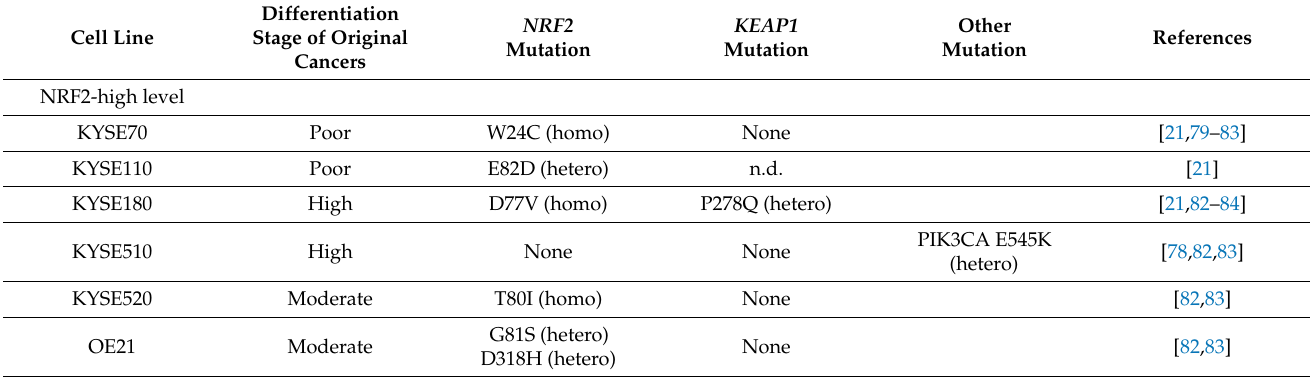
Table 1. Classification of ESCC cell lines in NRF2 activation. n.d., not